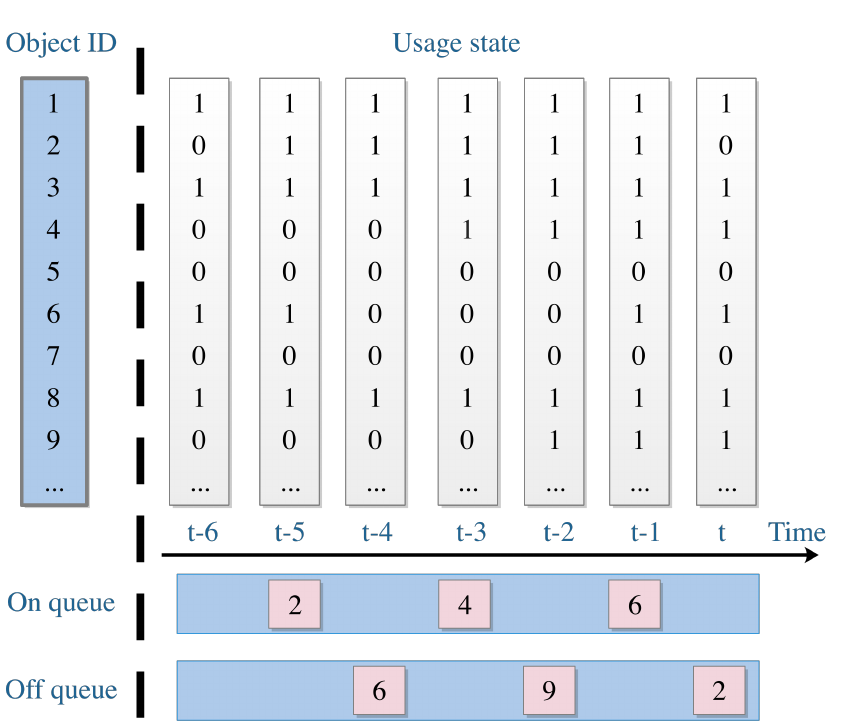
Figure 4. Object-usage state vector changes with time, and we can generate “On queue” and “Off queue”,